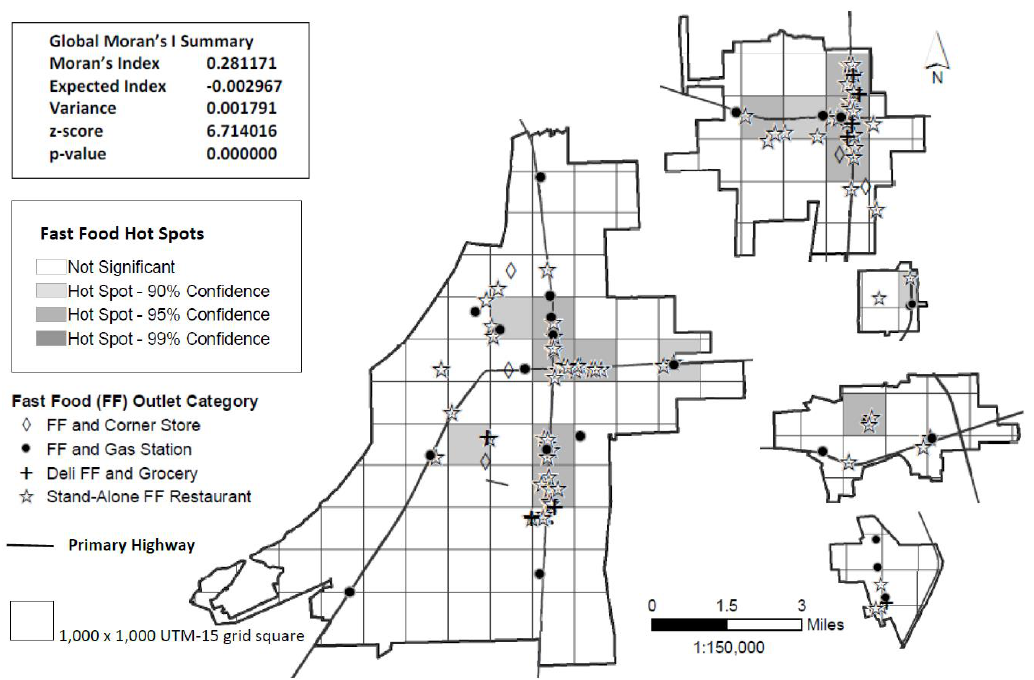
Figure 2. Spatial distribution and clustering (hot spots) of fast food restaurants in five rural Lower Mississippi Delta towns.